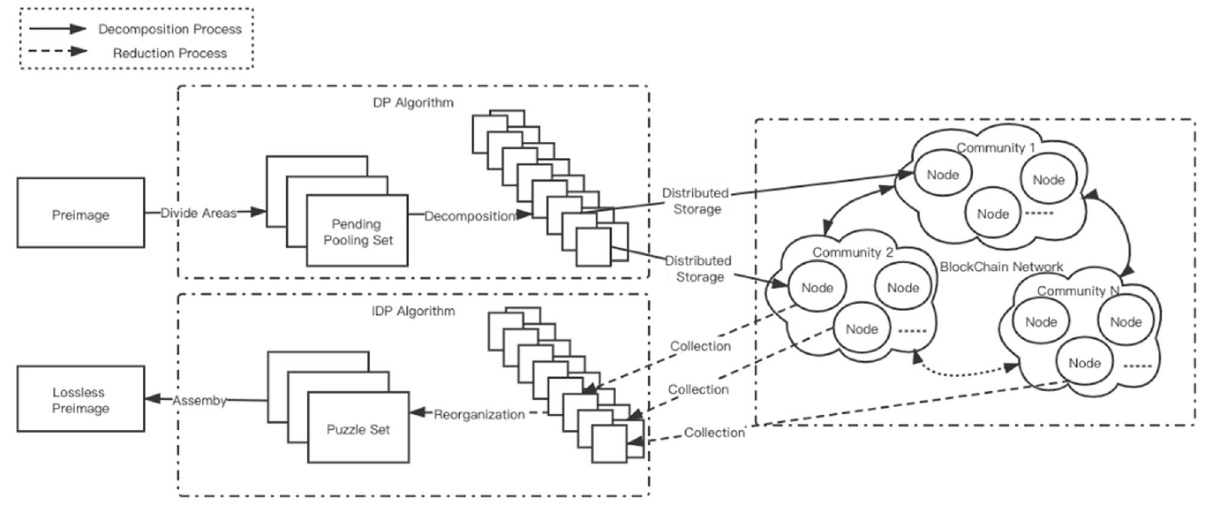
Figure 1. Architecture of distributed image storage